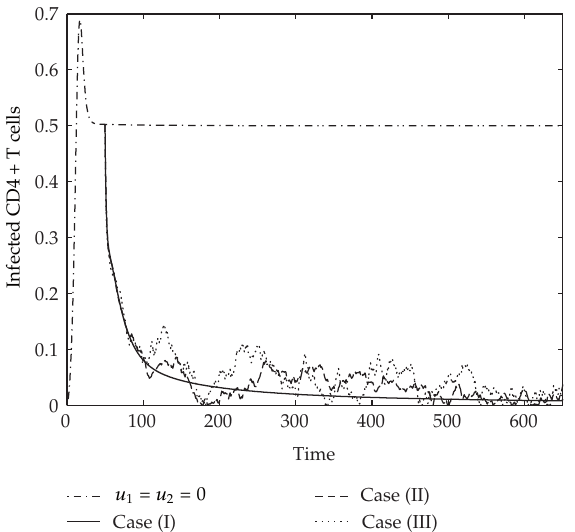
Figure 2: The evolution of infected CD4 (cid:4) T cells.